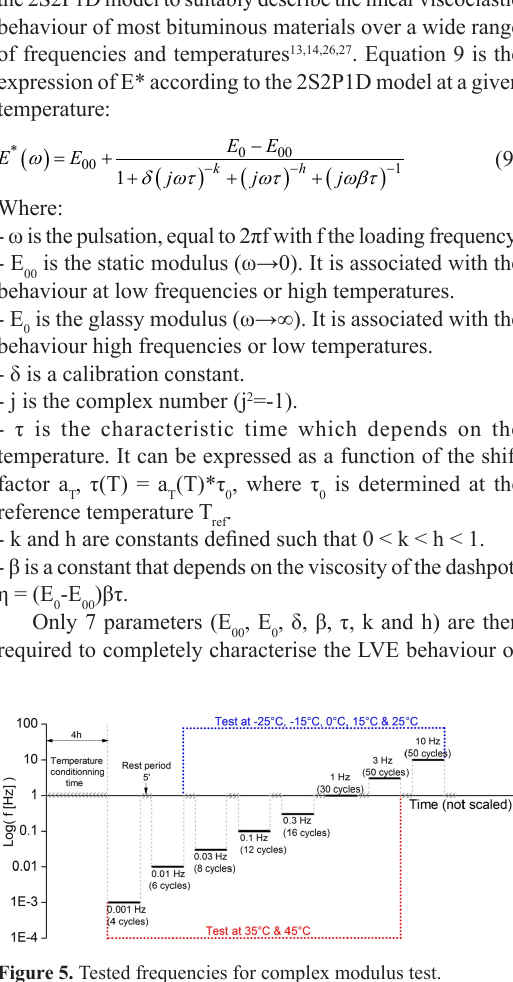
Figure 5. Tested frequencies for complex modulus test.